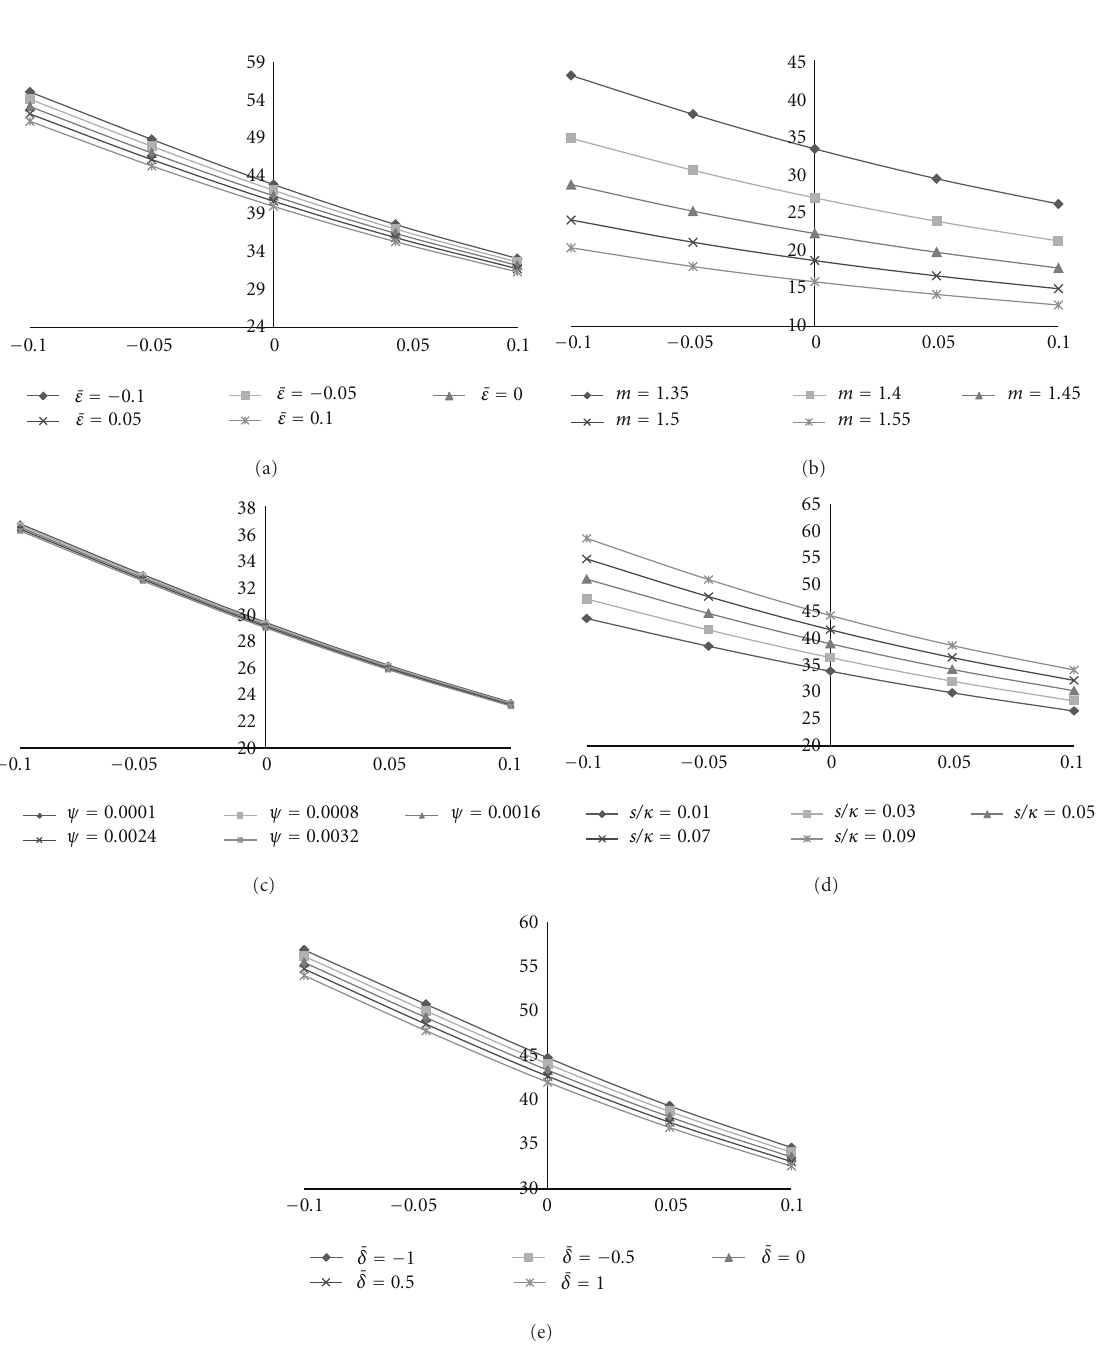
Figure 4: (a)–(e) Variation of load-carrying capacity with respect to α and ε , m , ψ , s/κ , δ .